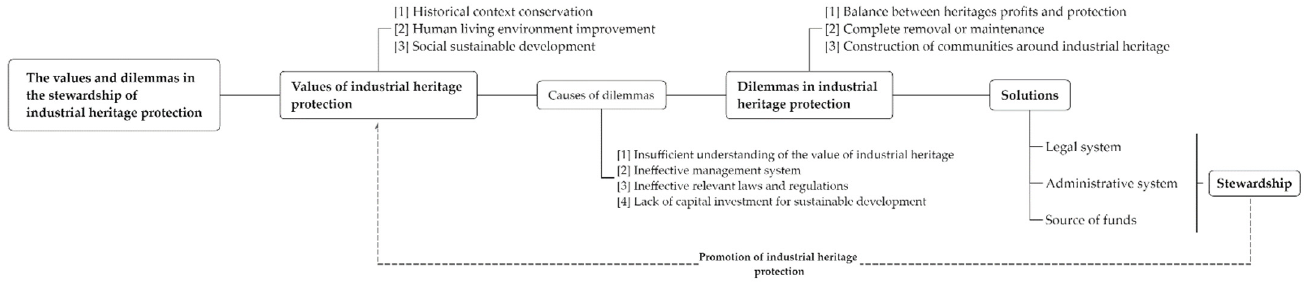
Figure 1. The intersection of values and dilemmas in the stewardship of industrial heritage protec-